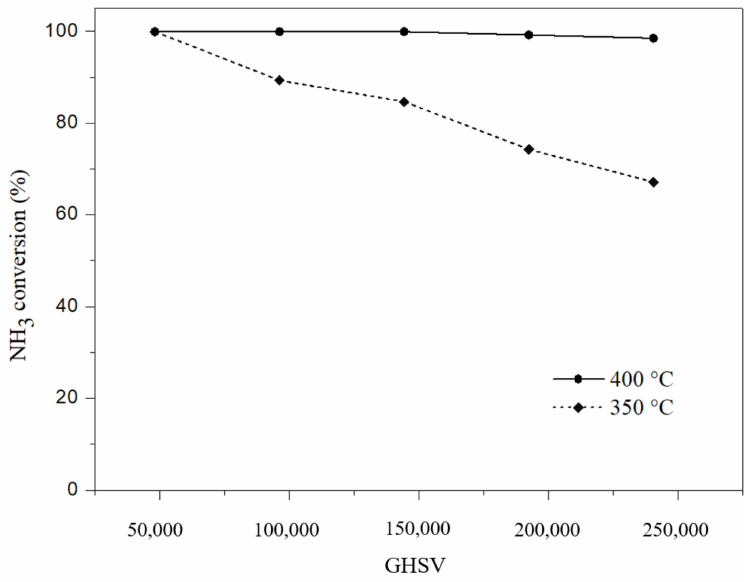
Figure 7. The variation of the ammonia conversion with gas hourly space velocity (GHSV) (mL h − 1 · gcat − 1 ) for Ru/C catalysts promoted with Cs/Ru molar ratio of 4.5 and Ru loading of 3.73